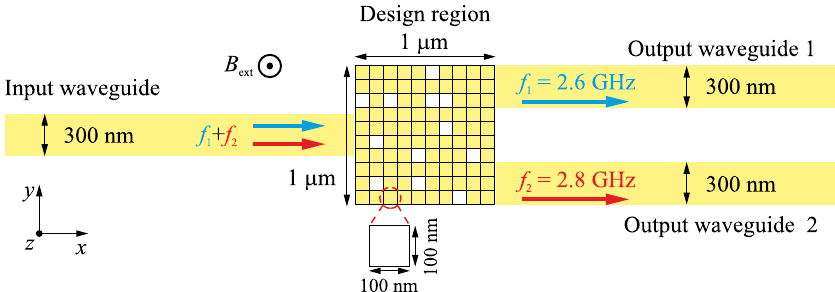
Fig. 1 Structure of the inverse-designed magnonic frequency demultiplexer. The magnonic frequency multiplexer consists of one input waveguide and two output waveguides with a width of 300 nm which are connected by a 1 × 1 μ m 2 design region. The design region has been divided into 10 × 10 elements each with a size of 100 × 100 nm 2 . The yellow region indicates the magnetic material (YIG) and the white holes imply that the material has been fully removed. An external fi eld of 200 mT is applied along the z -axis.